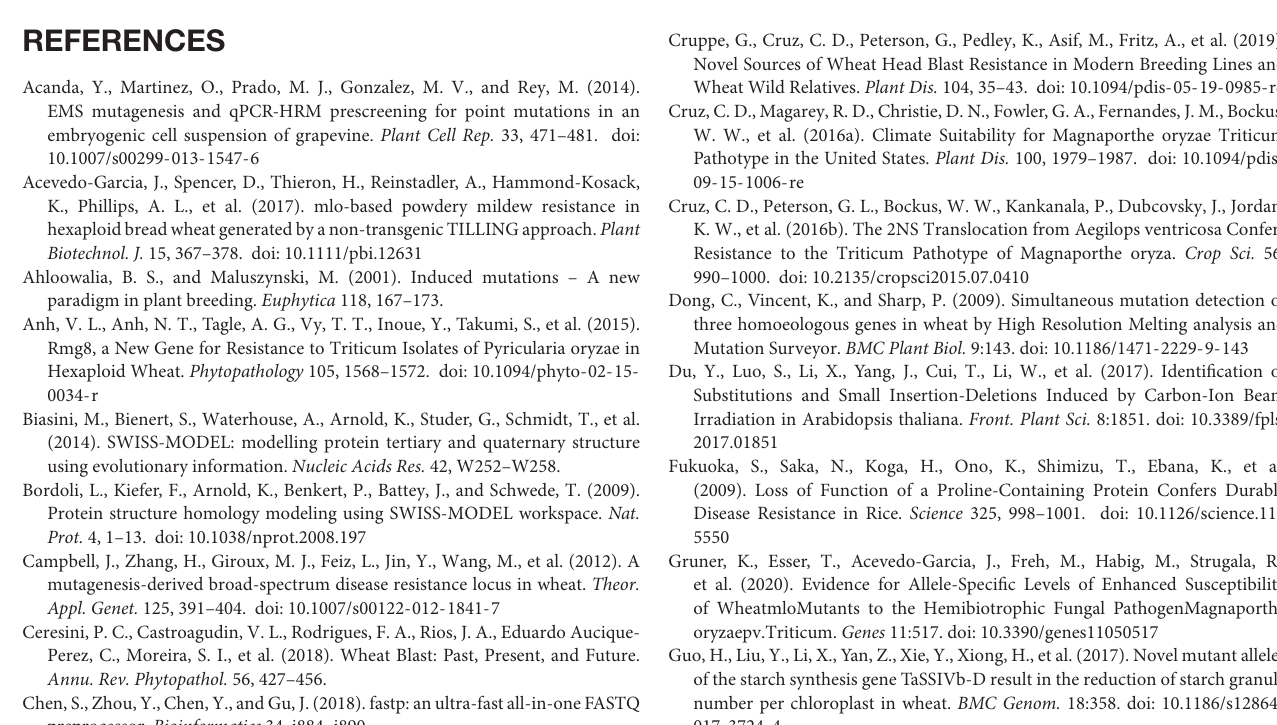
Supplementary Figure 1 | Diagram showing the sample pooling procedure on a 96-well-plate. The 12 samples corresponding to the gray line C were pooled into a single line-pooling-sample, while the eight samples in the blue row seven were pooled into a separate row-pooling-sample. The green sample detected in both line- and row-pooling-samples was considered a positive mutant, whereas the pink sample only detected in the row-pooling-samples was considered a negative mutant. Supplementary Figure 2 | Structure of orthologous genes of (A) Bsr-k1 (located on chromosomes 1A, 1B, and 1C) and (B) Bsr-d1 (located on chromosomes 7A, 7B, and 7D). Supplementary Figure 3 | Verification of the amplicons of gene TraesCS1A02G207700 by agarose gel electrophoresis. Forty-eight samples (E1–H12) from one of the 96-well pooling plates. M, DNA marker with fragment size of 15,000, 8,000, 6,000, 4,000, 3,000, 2,000, 1,000, and 500 bp. Supplementary Figure 4 | An example of amplification using specific primers in M3 mutant lines of E325, E786, and E60 by agarose gel electrophoresis. E325-1, E325-2 mean the different M3 individuals of mutant E325, and so on down the gel. Supplementary Figure 5 | Secondary structure of BSR-K1 wheat orthologs and mutants. (A) WT and mutant E325 of TraesCS1A02G207700; (B) WT and mutant E786 of TraesCS1B02G221400; (C) WT and mutant E724 of TraesCS1D02G211000. The mutant residue is highlighted by black triangle, and the variation secondary structure is highlighted in red